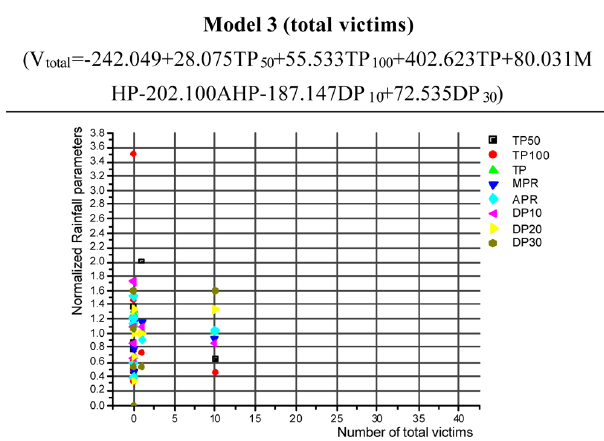
Fig. 13. The relationship between each extreme rainfall parameter and the total